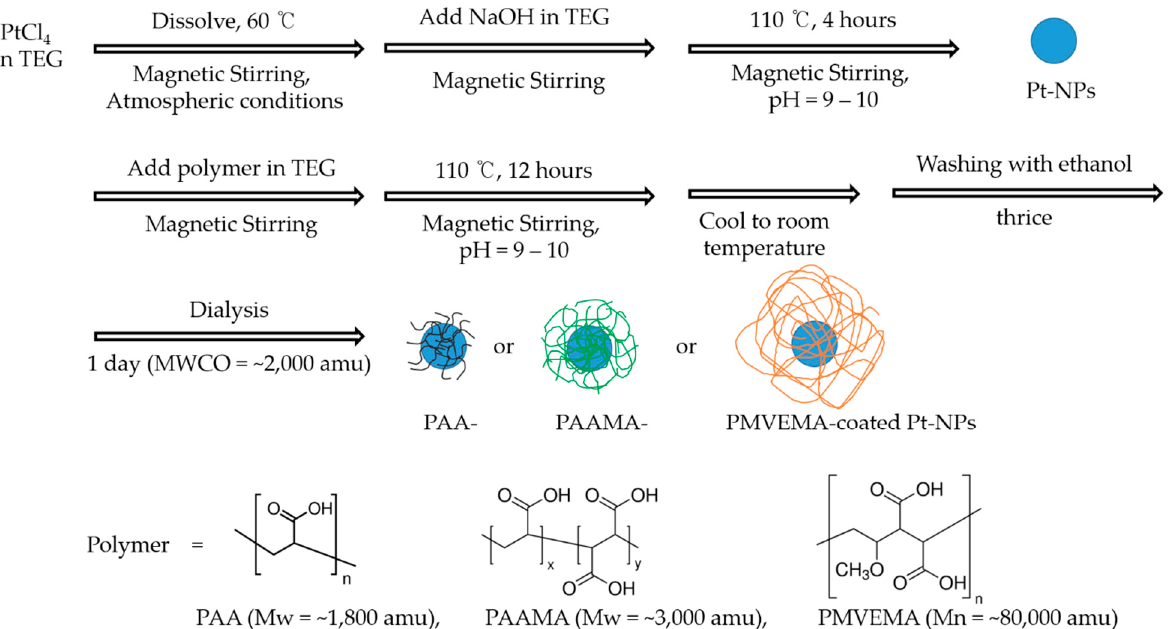
Figure 1. One-pot polyol synthesis of ultrasmall Pt-NPs coated with hydrophilic and biocompatible polymers: polymer = PAA or PAAMA or PMVEMA.